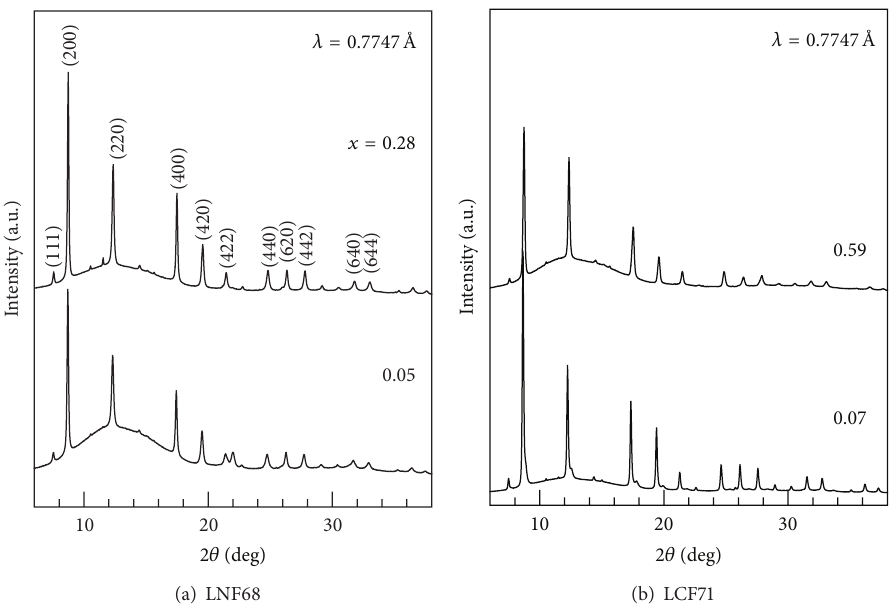
Figure 14: XRD pattern of powered (a) LNF68 and (b) LFC71 against 𝑥 . Values in parentheses represent indexes in the face-centered cubic setting (cited from